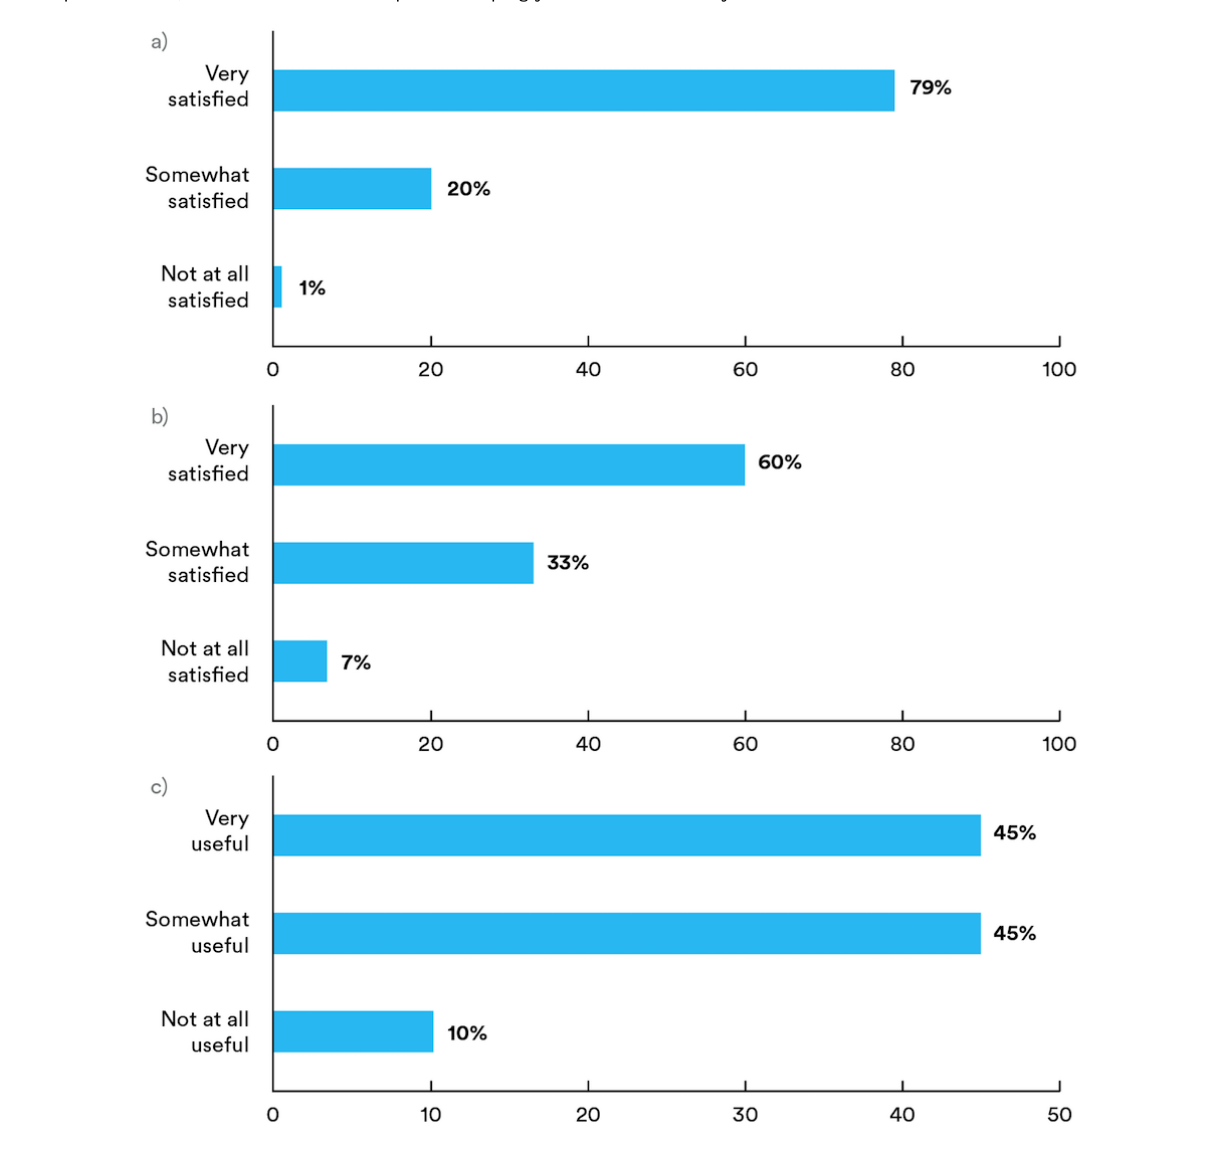
Figure 2. Participants’responses to closed-ended questions: a) “How satisfied were you with the inhaler device?” b) “Overall, how satisfied were you with the reports?” and c) “How useful were the reports in helping you learn more about your